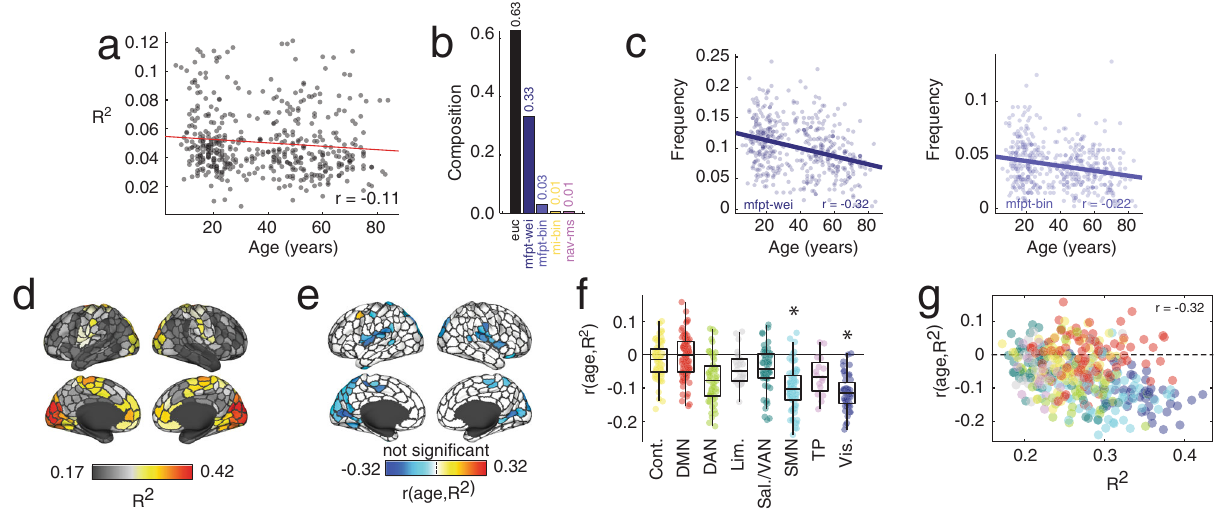
Fig. 6 Lifespan variation in structure-function coupling based on communication models. a Decreases in whole-brain variance explained across the lifespan. b Distribution of optimal predictors for each subject across the lifespan. c Correlations between age and the frequency with this weighted and binary mean fi rst passage time were the optimal predictor of regions' FC patterns. d Whole-brain pattern of variance explained. e Correlation of variance explained with age projected onto the cortical surface. f Correlation of variance explained grouped by brain system (asterisks indicate statistical signi fi cance). Each point represents a brain region ( N = 400 parcels de fi ned based on 40 ). In each boxplot, the “ box ” denotes interquartile range (IQR), the horizontal bar indicates the median value, and the whiskers include points that are within 1.5 × IQR of upper and lower bounds of the IQR (25th and 7th percentiles). Any points that fall beyond the whiskers are, by convention, considered outliers. g Scatterplot of variance explained versus the correlation of variance explained and age. Source data are provided as a Source Data fi